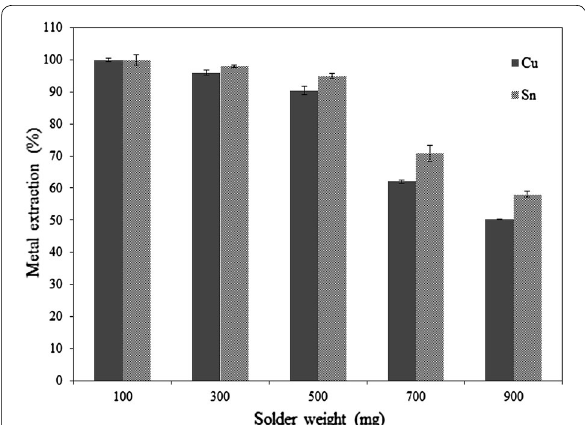
Fig. 6 Effect of increasing weight of Sn–Cu solder on metal recovery from by 4 ml acetic acid (80%) at 150 rpm shaking speed at 30 °C temperature and 30 h incubation